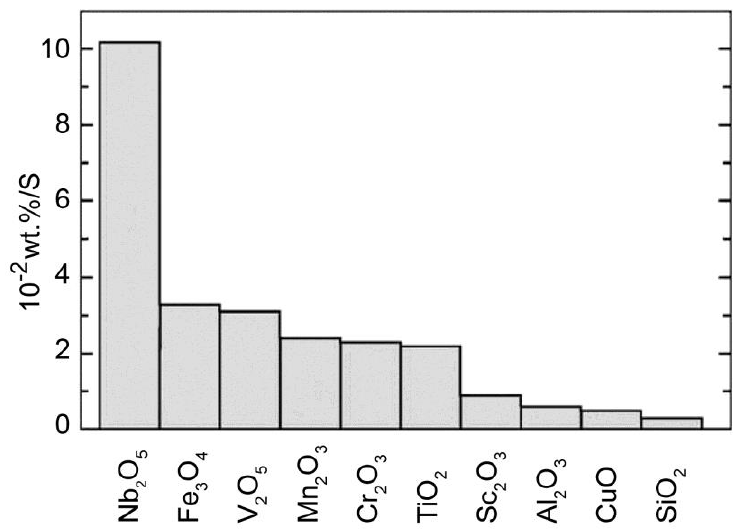
Figure 9. Comparison of the desorption rates of MgH 2 with different metal oxide catalyst additions at 300 °C into vacuum. Adapted with permission from [66], Copyright Elsevier, 2003. 300 ◦ C into vacuum. Adapted with permission from [66], Copyright Elsevier,